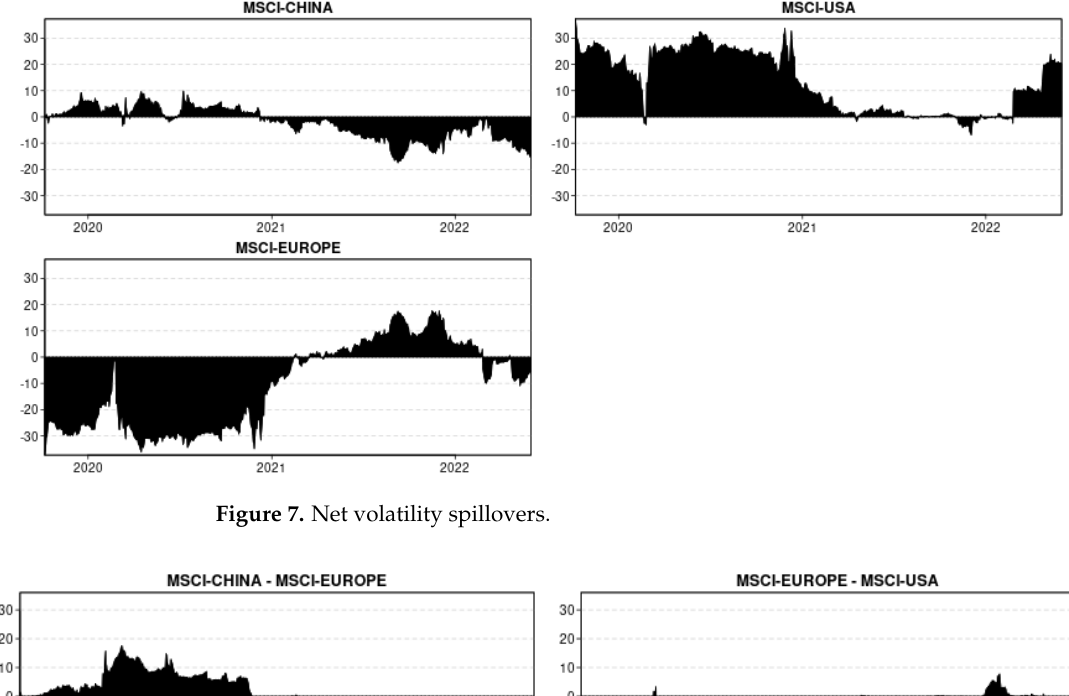
Figure 6. Directional volatility spillover to others.